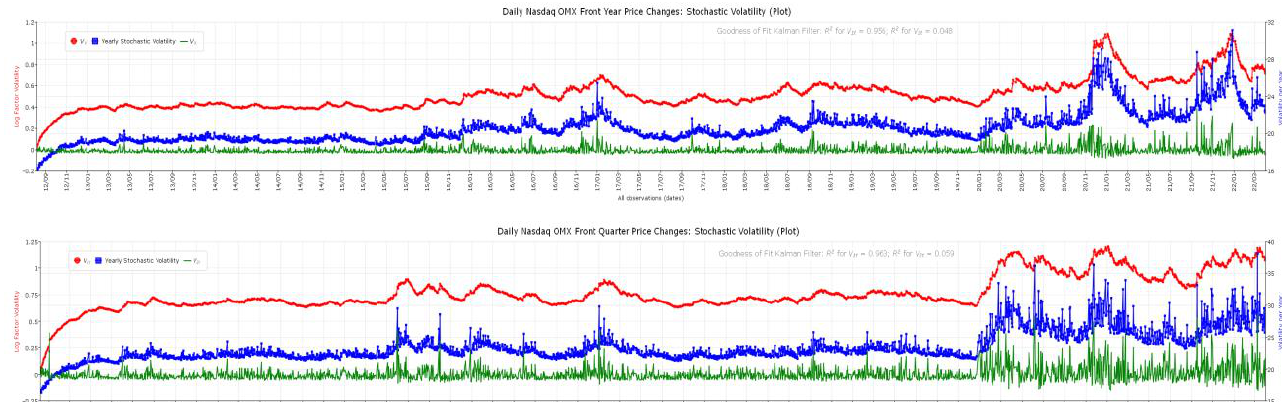
Figure 3. Stochastic Volatility from Observables using the Kalman Filter (daily). When Figures 1 and 3 are compared, the two synchronous plots demonstrate that as returns become broader (narrower), volatility increases (decreases). Furthermore, turbulent (wide returns) days are more likely to be followed by other turbulent days, and calm (narrow returns) days are more likely to be followed by other tranquil (wide returns) days (clustering). Table 3 summarizes the volatility measures for the two electricity contracts. The volatility from the front quarter is larger than from the front year contracts. The V 1 ( V 2 ) factor for the front year contracts reports a mean of 0.52 ( − 0.002) with a standard deviation of 0.14 (0.04). The higher volatility for the front quarter contracts is confirmed by a mean for V 1 ( V 2 ) of 0.77 (0.004) and standard deviation of 0.16 (0.07). Moreover, due to the mean size differences for V 1 and V 2 , the stochastic volatility for both contracts 252 e ( V 1 + V 2 )) seems dominated by the V 1 factor. The characteristics for V 1 will therefore most likely also